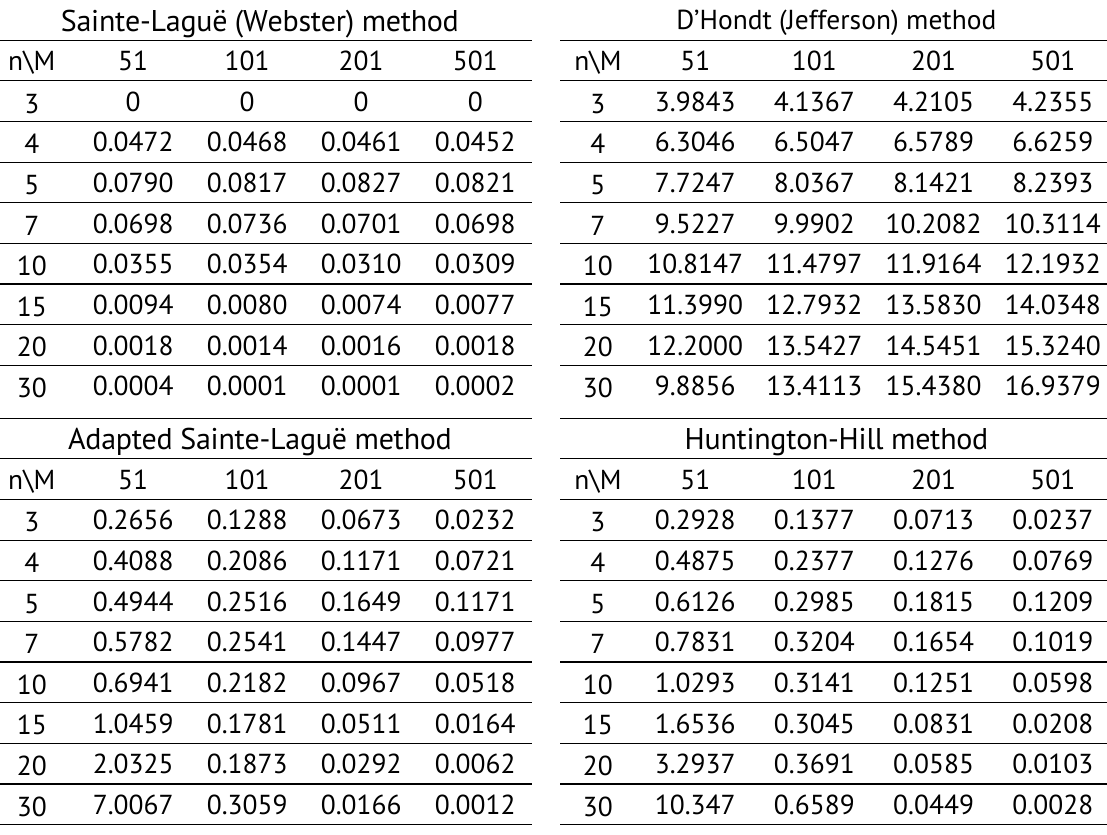
Percentage P of Quota rule violation by divisor APP methods, % Q Sainte-Laguë (Webster)